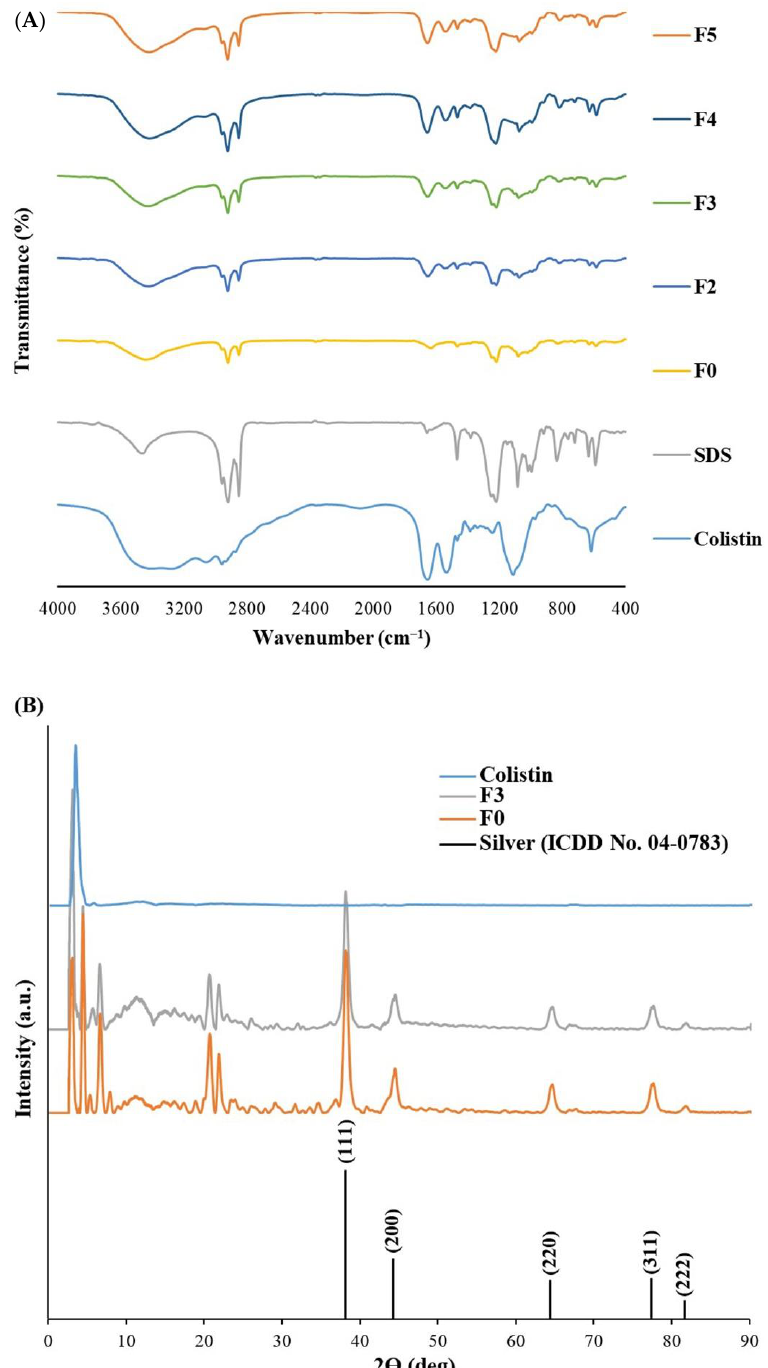
Figure 3. FT-IR and PXRD analysis of nanoparticles. ( A ) FT-IR spectra of colistin, SDS, AgNPs in F0, and Col-AgNPs in F2–F5, and ( B ) PXRD patterns of colistin, AgNPs in F0, and Col-AgNPs in